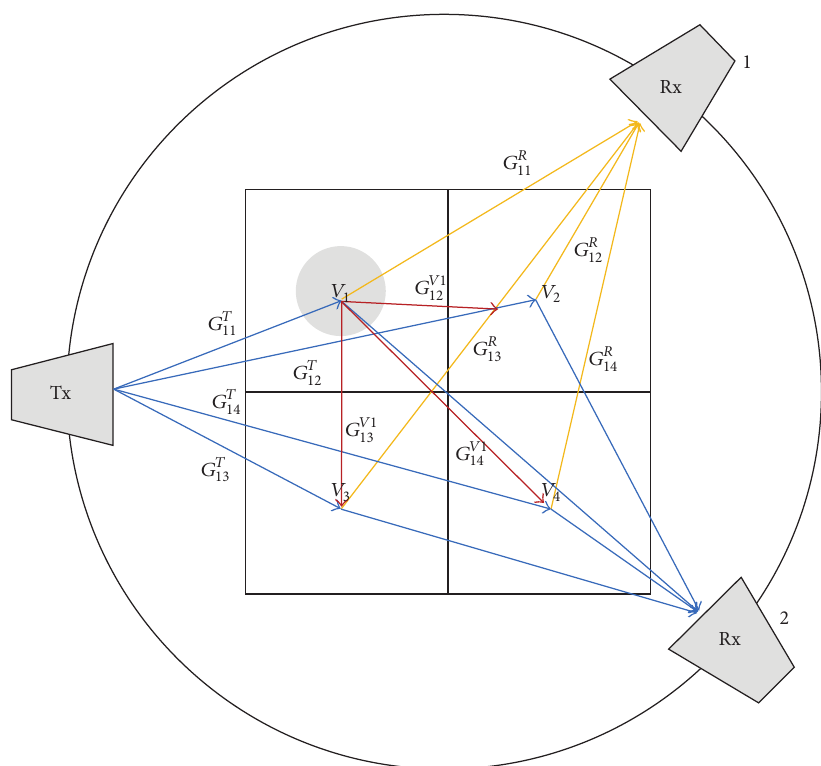
Figure 4: The effect of the secondary dipole modeled in cell